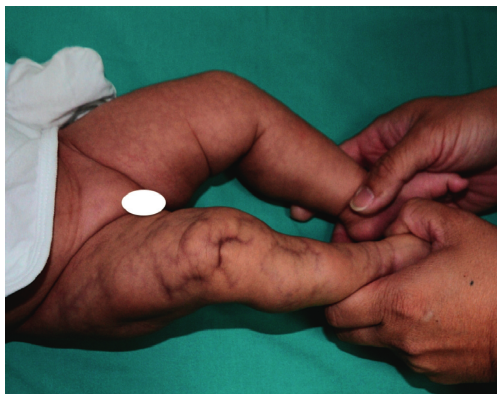
Figure 3: Cutis marmorata telangiectatica congenita on the right lower limb associated with ipsilateral Table 1: Cutis marmorata telangiectasis congenita with hemiatrophy.